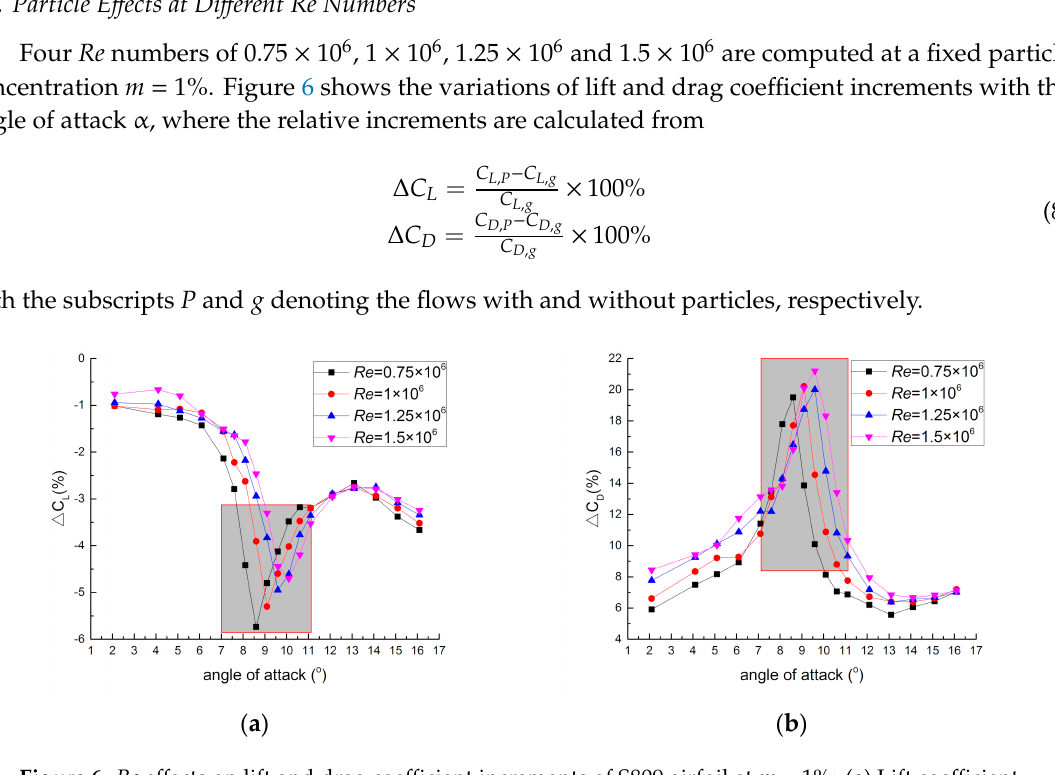
Figure 6. Re effects on lift and drag coefficient increments of S809 airfoil at m = 1%: ( a ) Lift coefficient Figure 6. Re e ff ects on lift and drag coe ffi cient increments of S809 airfoil at m = 1%: ( a ) Lift coe ffi cient increment; ( b ) drag coefficient increment. increment; ( b ) drag coe ffi cient